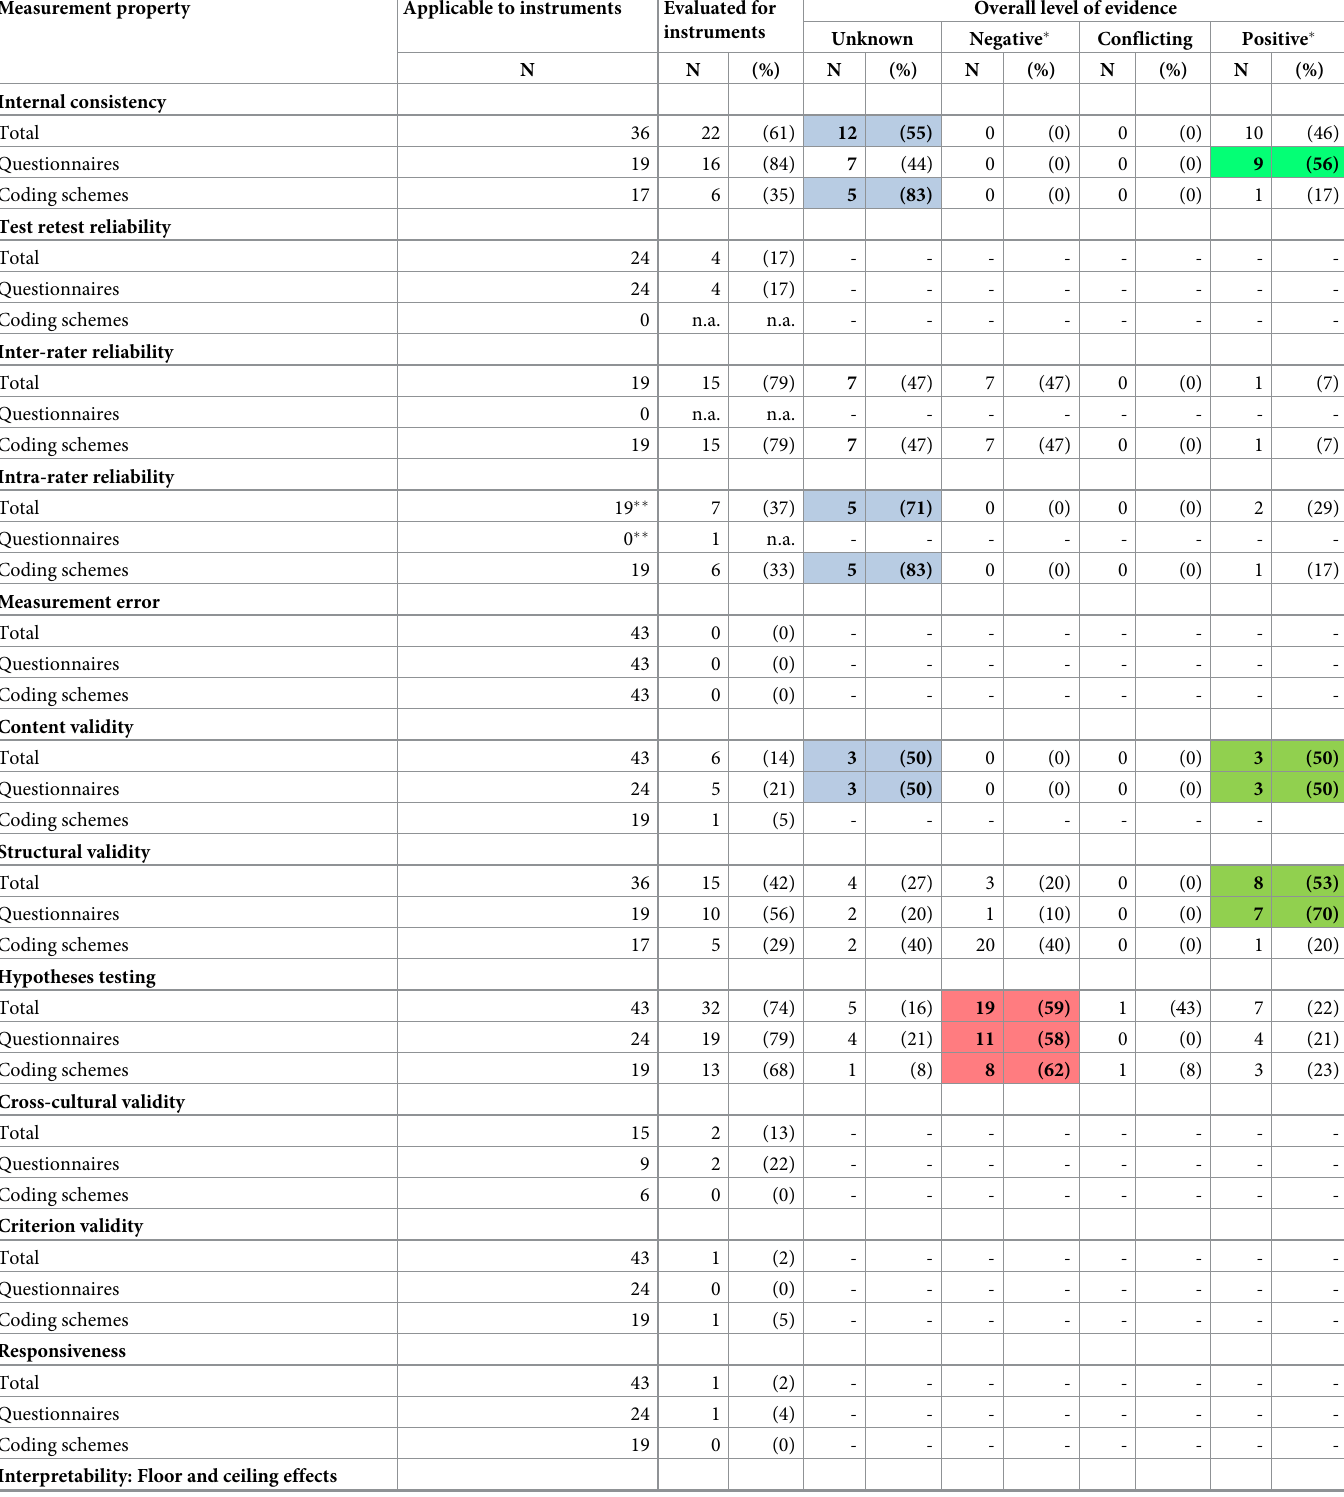
Table 7. Overall results on best-evidence synthesis per measurementproperty of instruments measuring the process of SDM (N =